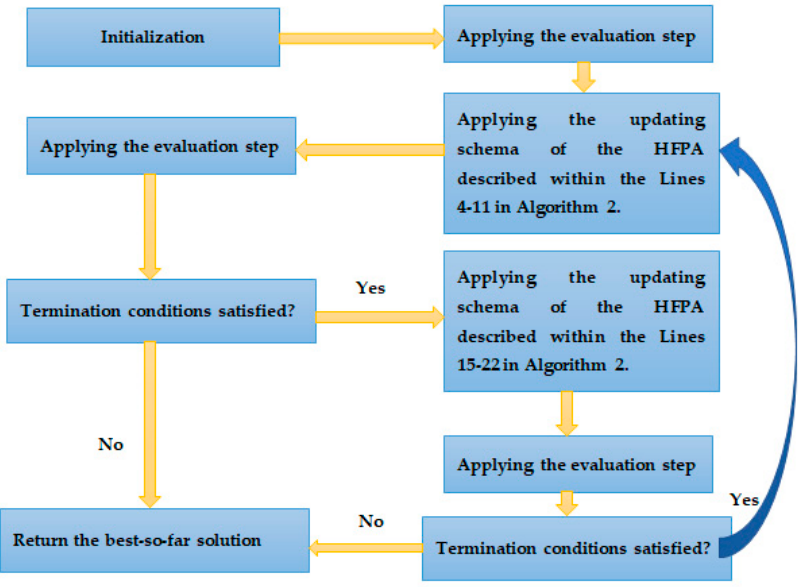
Figure 3. Framework of the proposed algorithm: HFPA.